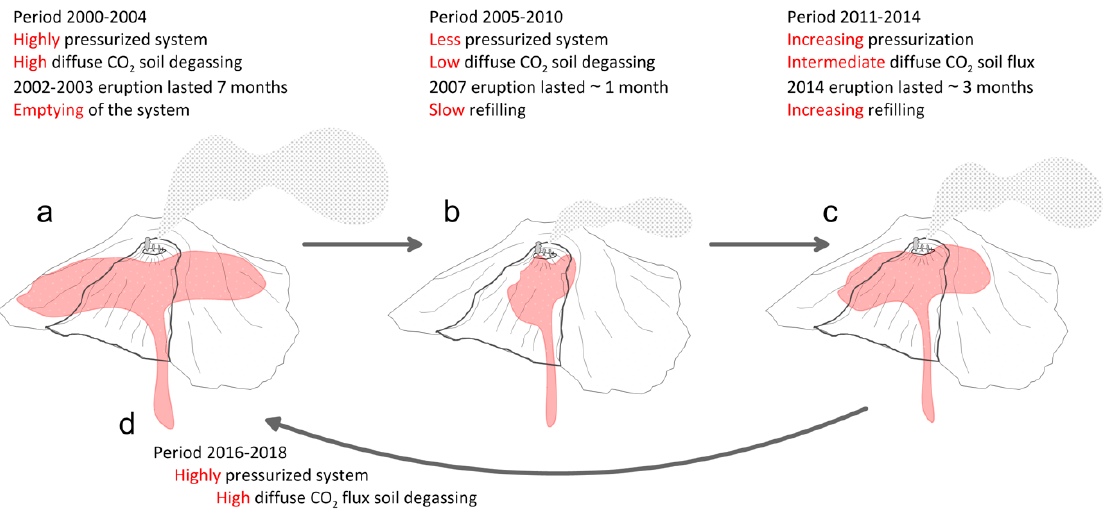
Figure 6. Conceptual sketch map of Stromboli and extent of affected magmatic volatiles–surficial fluids interaction zone (pink regions), showing the four main stages of volcanic activity inferred from its CO 2 degassing behavior.